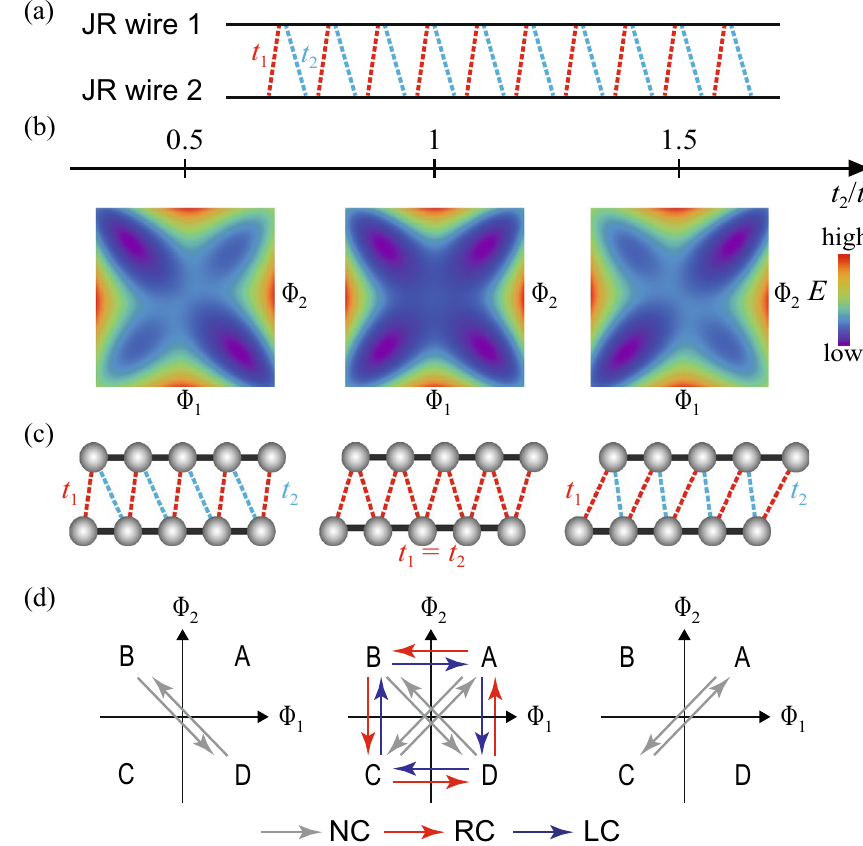
Figure 2. ( a ) Schematic for the generalized JR model composed of two JR wires and two interwire couplings ( t 1 and t 2 ). In each i th JR wire, the i th fermion and bose fields, � i ( t , x ) and � i ( t , x ) , reside. ( b ) Total energy profiles, ( c ) the corresponding lattice models, and ( d ) diagrams of possible solitons in the order parameter space ( (cid:31) 1 , (cid:31) 2 ) for three t 2 / t 1 values. In ( d ), nonchiral (NC), right chiral (RC), and left chiral (LC) solitons are represented by grey, red and blue arrows, respectively. A, B, C, and D indicate global and local